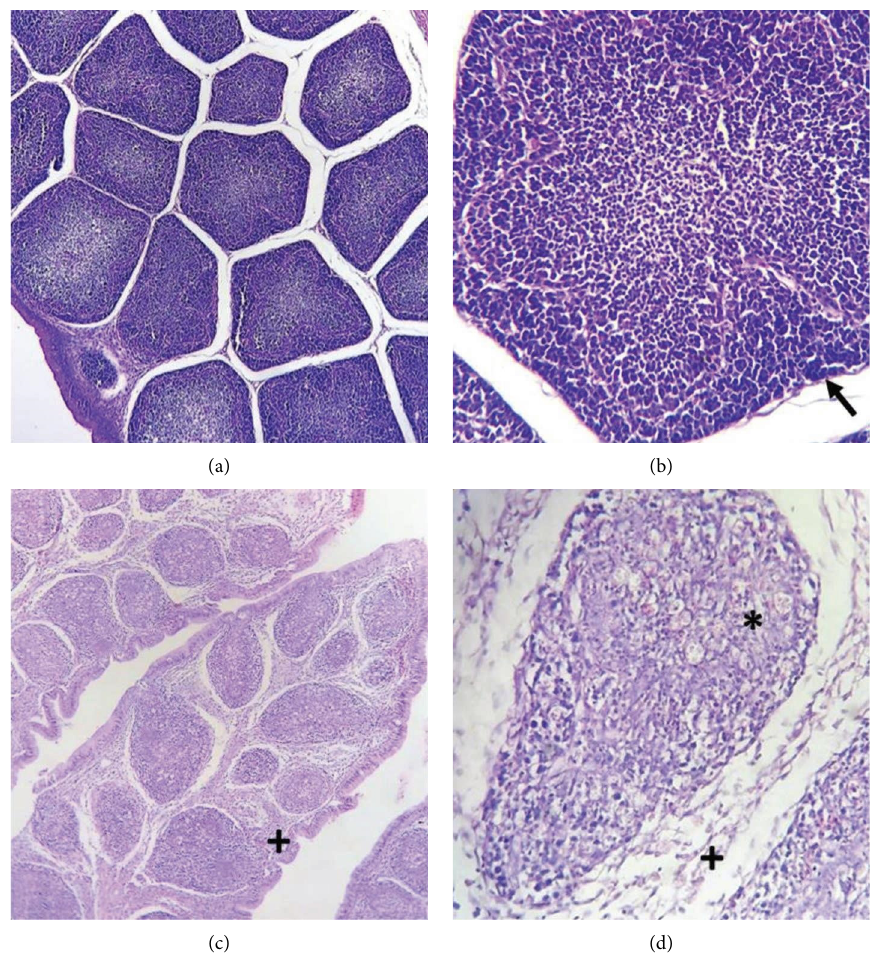
Figure 2: Representative photos of bursal lesions. Te arrow indicates the presence of lymphocytes in the cortex, ( ∗ ) points the absence of lymphocytes in the cortex and (+) shows the infammatory infltrate. (a and b) Photographs of a healthy bursa. (c and d) A bursa with the highest score in the measured